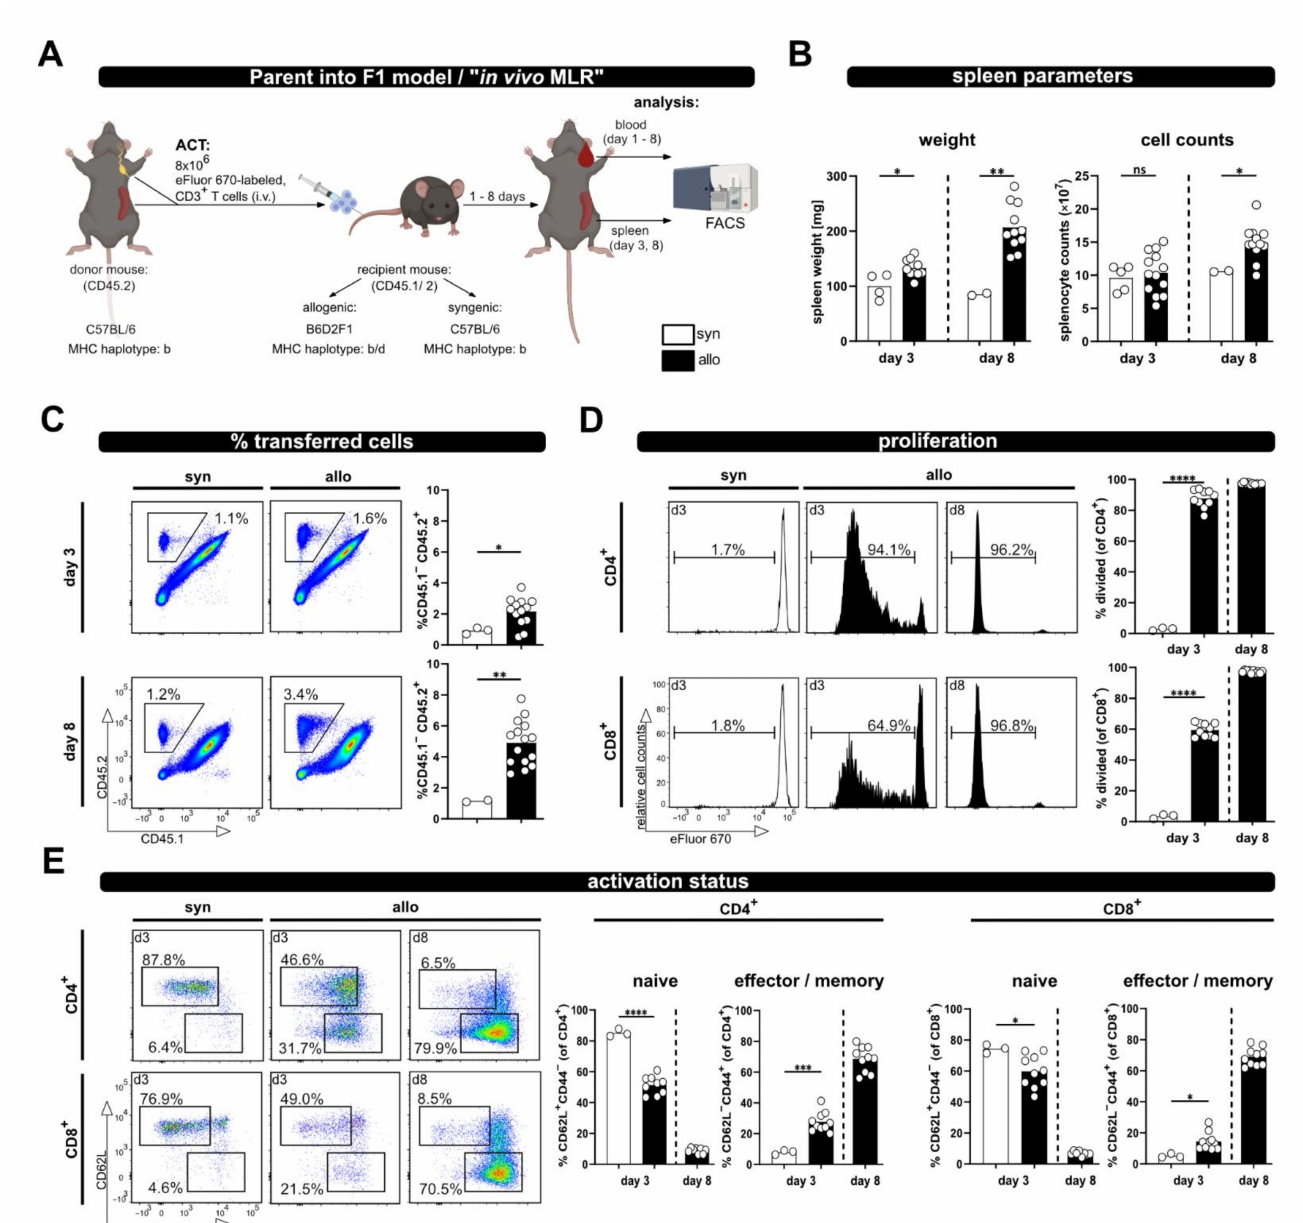
Figure 1. The P → F1 approach to analyze T cell activation in vivo in spleen and blood. ( A ) Experi- mental setup: 8 × 10 6 wild type; eFluor670 proliferation dye-labeled CD3 + T cells were adoptively transferred i.v. to either syngenic or allogenic recipients. Transferred T cells were analyzed from spleen and blood of recipient mice by flow cytometry at the indicated time points. ( B ) Spleen weight and splenocyte counts at day 3 and 8 after ACT. ( C ) The frequency of transferred T cells (CD45.2 + ) in the spleens of allogenic or syngenic recipients (both CD45.1 + /2 + ) was determined by flow cytometry using CD45.1 and CD45.2 specific antibodies. ( D ) T cell proliferation was analyzed based on dilution of the proliferation dye eFluor670 with each cell division. Proliferation of transferred CD4 + and CD8 + T cells is depicted as percent of divided cells. ( E ) The frequency of naive and effector/memory subsets among transferred CD4 + and CD8 + T cells was determined by CD44 and CD62L staining. Data are represented as individual values plus mean. Representative FACS dot plots or histograms of individual mice are shown. ns = not significant, * p < 0.05, ** p < 0.01, *** p < 0.001, **** p < 0.0001; unpaired t